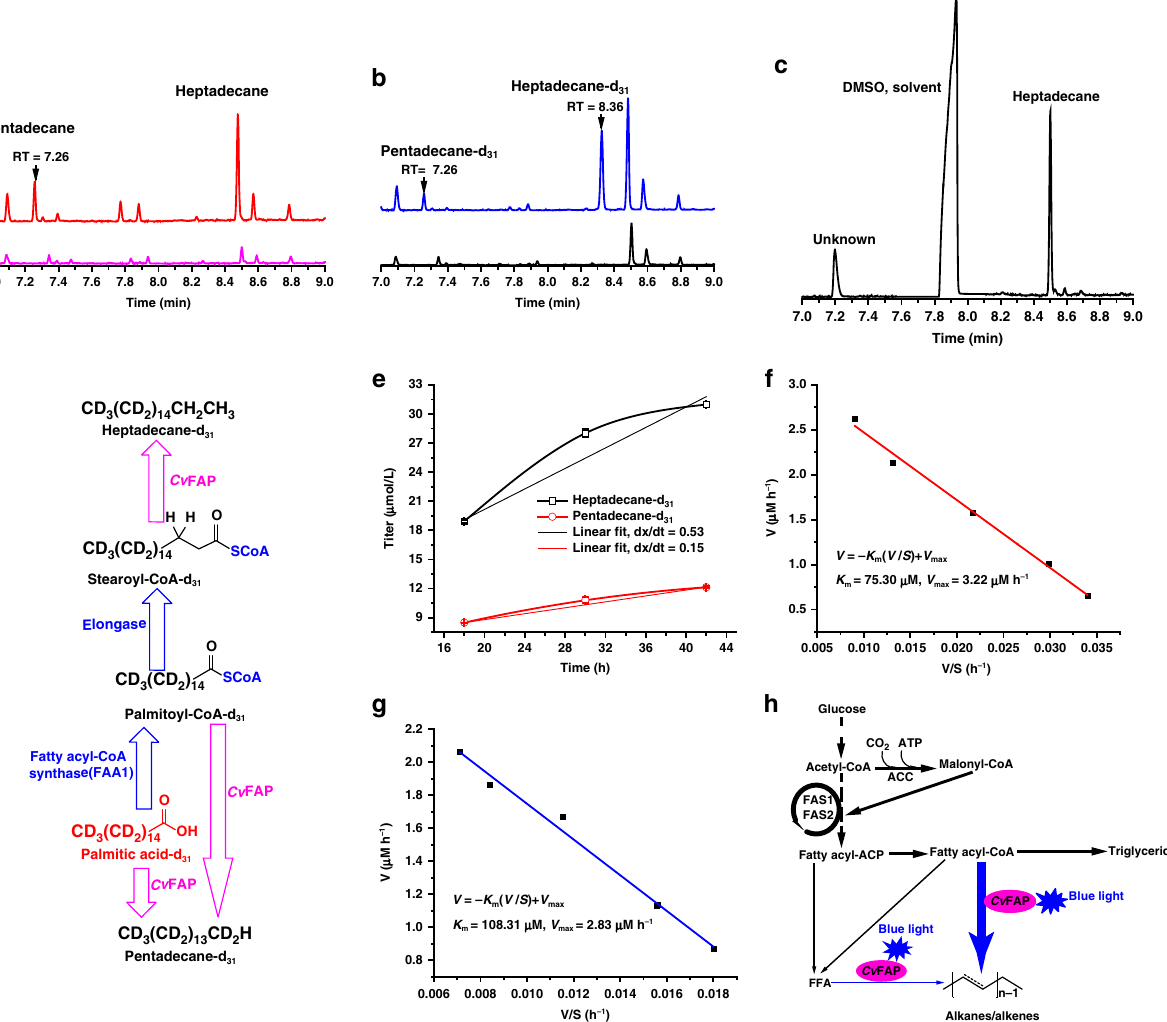
Fig. 2 A proposed metabolic pathway for alka(e)ne synthesis in Y. lipolytica . a , b GC chromatograms from strain YLjbl-2- Δ FAA1 (red) and strain YLjbl-2 (blue) cultivated with exogenous palmitic acid-d 31 supplementation, respectively. Magenta and black lines represent the same cultivation without palmitic acid-d 31 addition. Two compounds with retention time of 7.26 and 8.36 min were found and identi fi ed to be pentadecane-d 31 and heptadecane-d 31 , respectively. c GC chromatogram of products from the in vitro photocatalytic reaction using stearoyl-CoA lithium salt ( ≥ 90%, Sigma-Aldrich) as the substrate and puri fi ed Cv FAP as the catalyst, showing that heptadecane could be synthesized from stearoyl-CoA. d Proposed mechanism for pentadecane- d 31 and heptadecane-d 31 formation from exogenous palmitic acid-d 31 . Blue arrows indicate endogenous pathways while magenta arrows represent